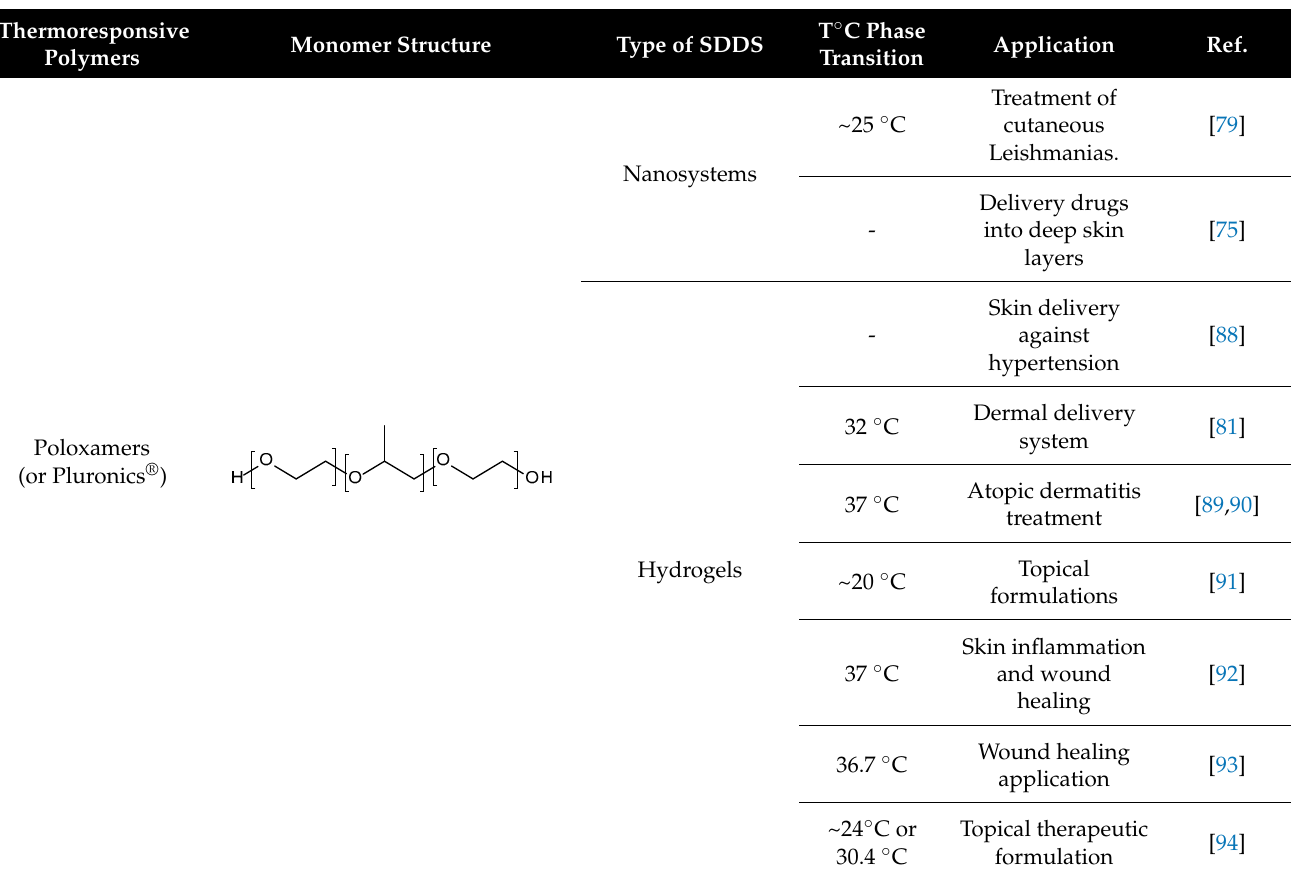
Various thermoresponsive polymers are used to develop thermoresponsive systems, usually hydrogels or nanogels, for the controlled drug delivery by cutaneous route (Table 2). Table 2. Structure and characteristics of thermoresponsive polymers used to design smart drug delivery systems for skin application.